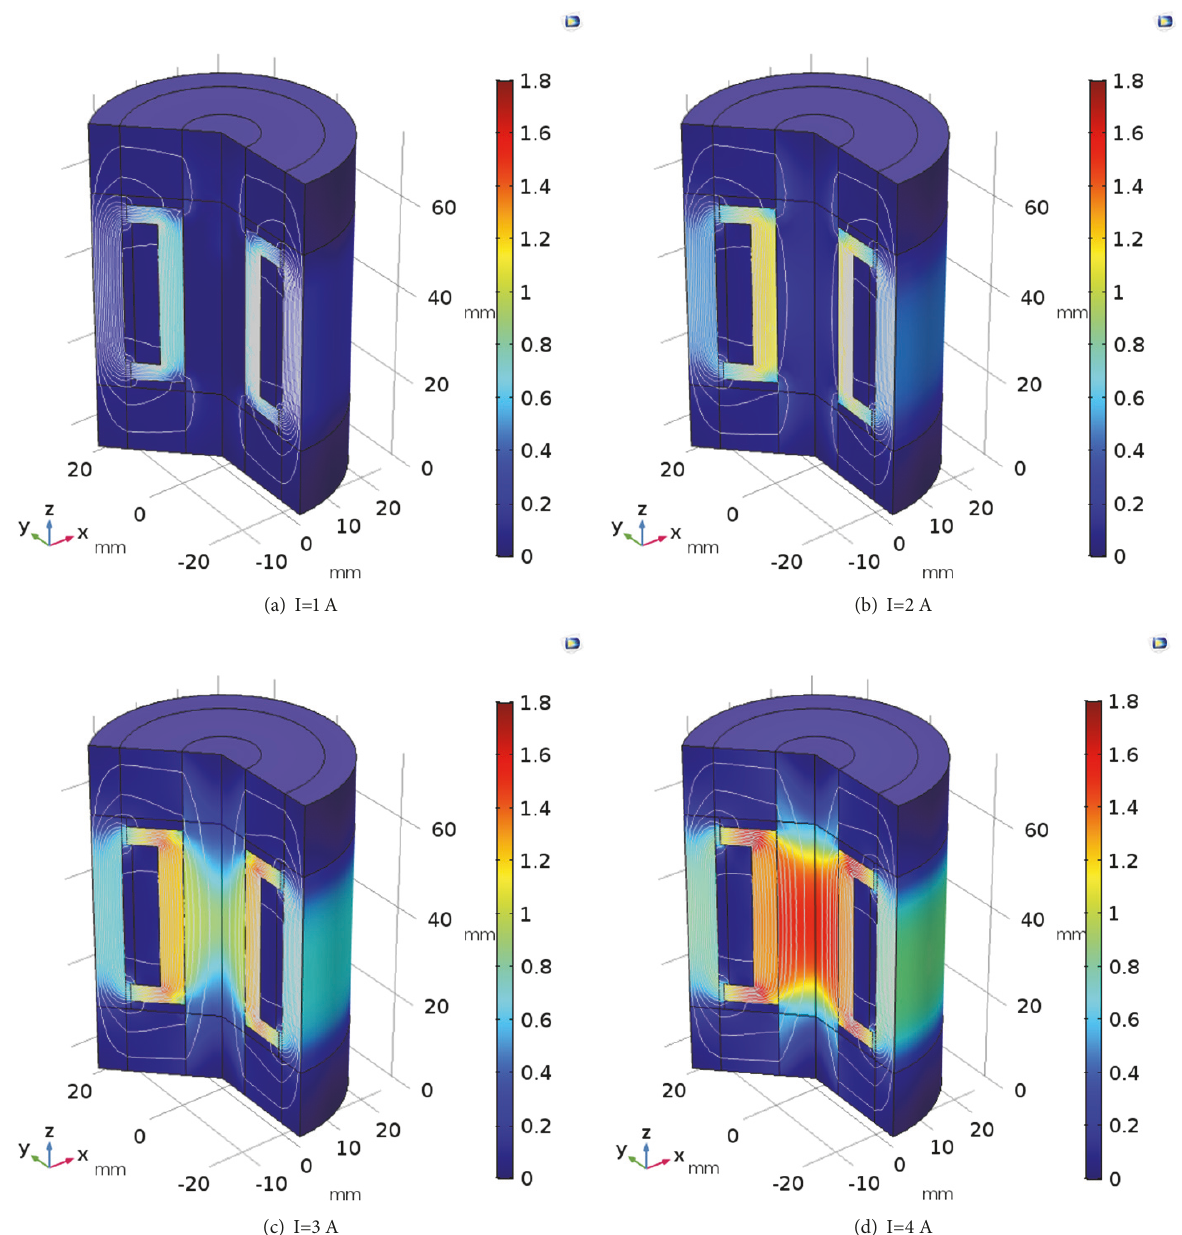
Figure 12: Magnetic field of the MRF damper with